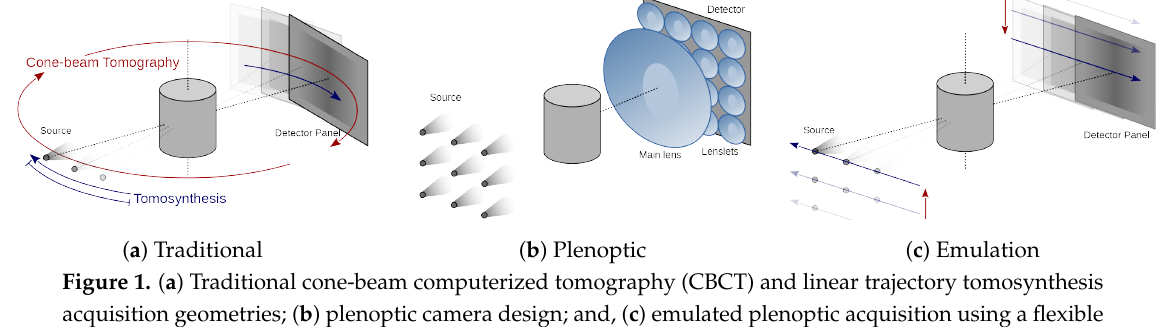
Figure 1. ( a ) Traditional cone-beam computerized tomography (CBCT) and linear trajectory tomosynthesis acquisition geometries; ( b ) plenoptic camera design; and, ( c ) emulated plenoptic acquisition using a flexible X-ray scanner.